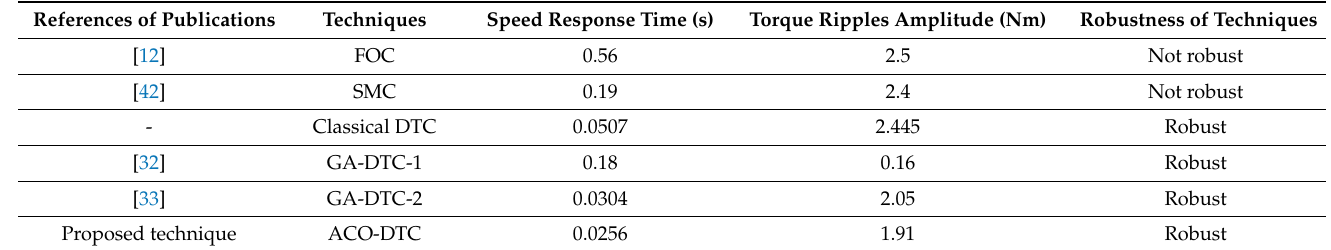
Table 5. Comparison between the proposed ACO-DTC and various methods that have just been published.